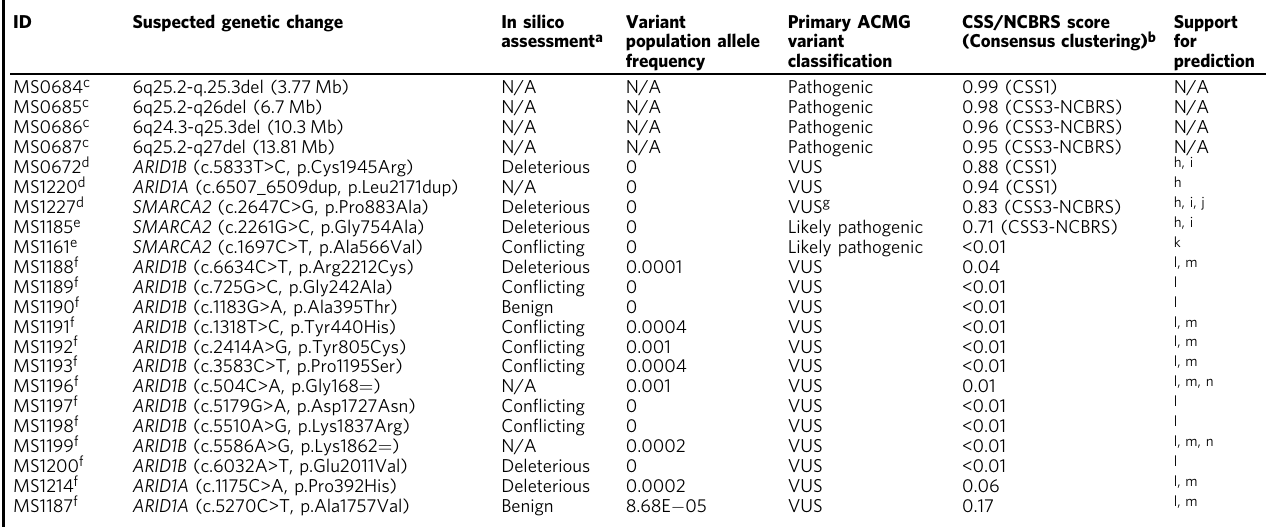
Table 2 Classi fi cation of subjects with Chr6q25 deletions, with variants of unknown signi fi cance in a CSS/NCBRS-related gene, or with a clinical suspicion for